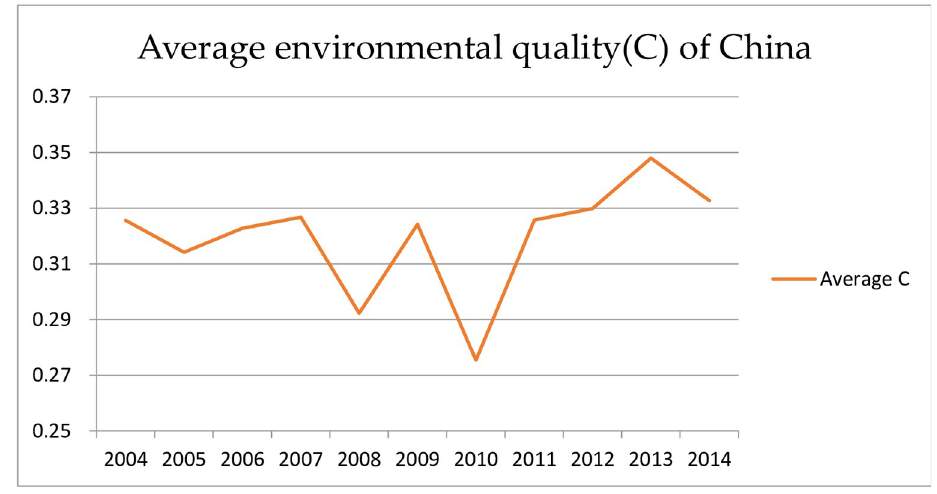
Fig 1. Environment quality (C) of